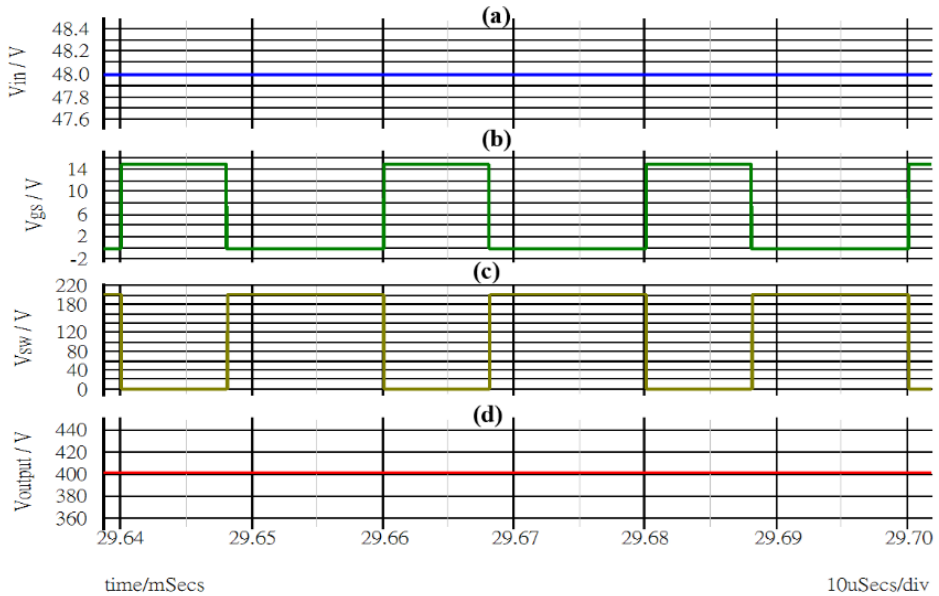
Figure 13. Simulated waveform of ( a ) input voltage (V in ), ( b ) duty cycle (V gs ) at duty d = 0.402, ( c ) switch’s voltage stress (V DS ), and ( d ) output Voltage (V 0 ).